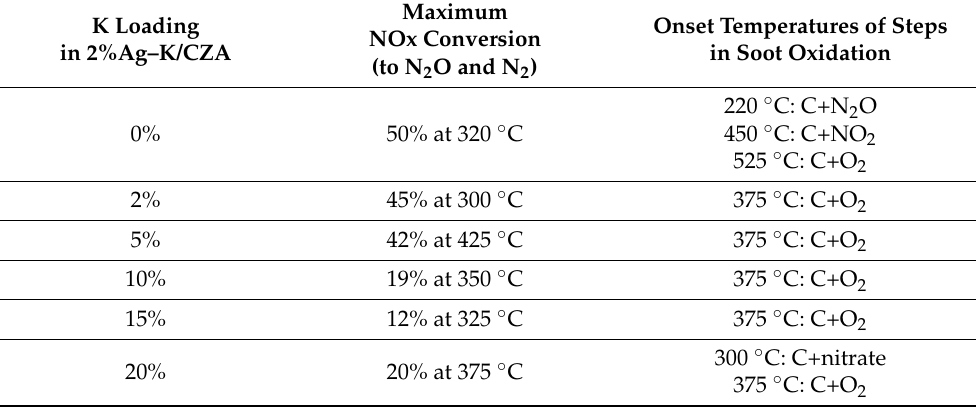
Table 2. Effects of potassium loading on NOx conversion and the onset of soot (carbon black) oxidation. K